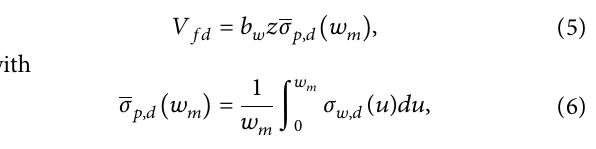
Figure 7: Crack pattern and shear failure of beams BSS ∞ SF0PF0 and BSS ∞ SF40PF4. (a) Shear failure and crack pattern of beam BSS ∞ SF0PF0. (b) Shear failure and crack pattern of beam BSS ∞